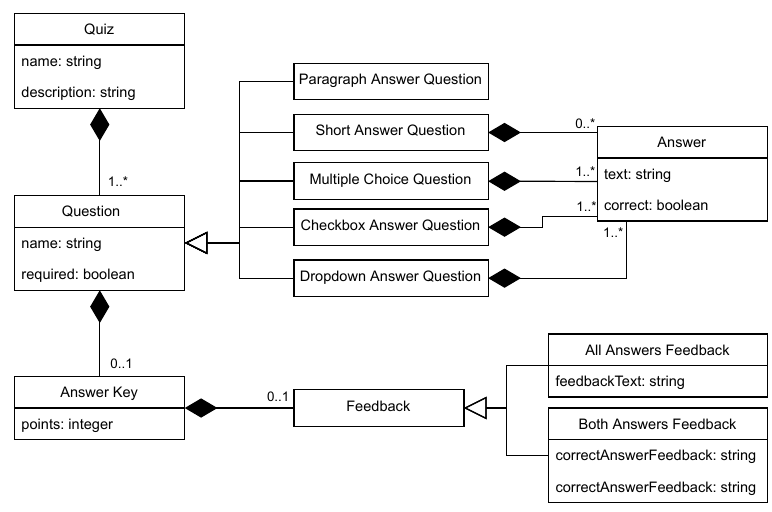
Figure 1. The metamodel of the simplified quiz definition